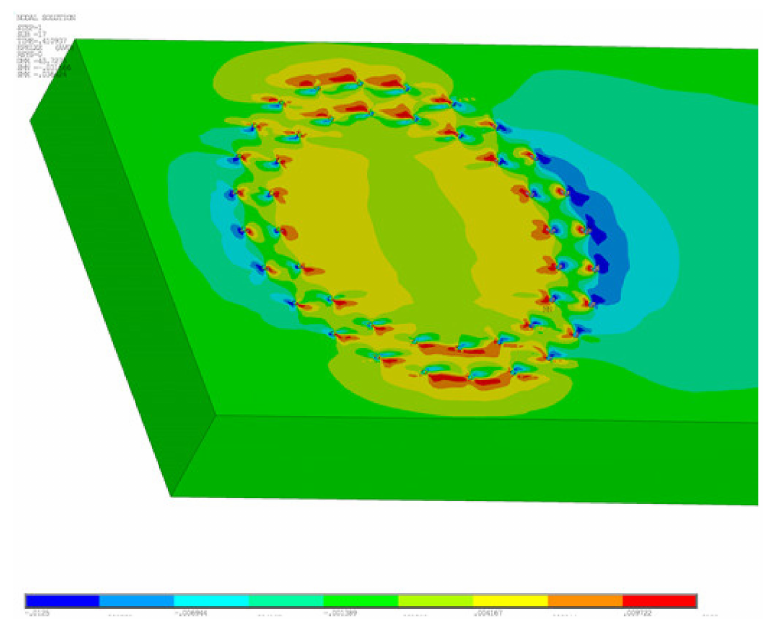
Figure 15. Computational model—strain ε XZ